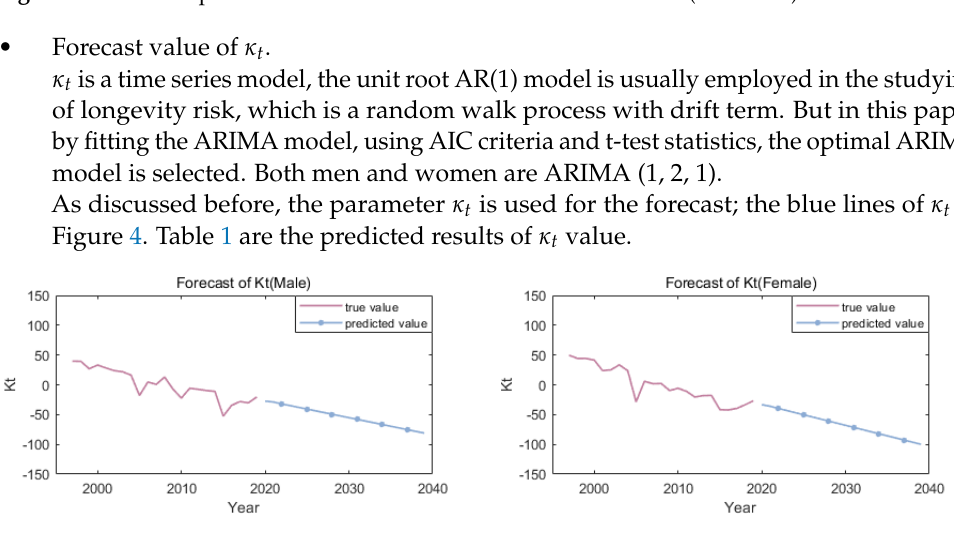
Figure 4. Observed (1997:2019) and 20 years ahead forecast (2020:2039) of κ t for males and